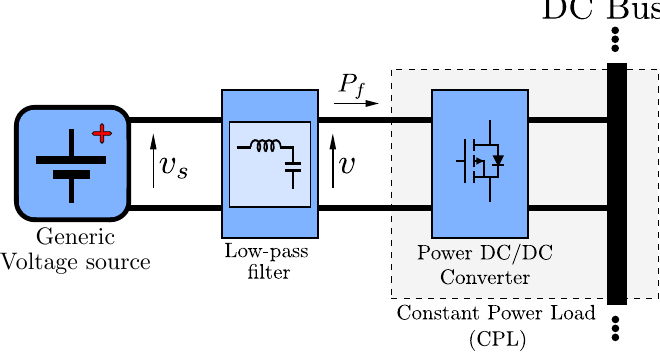
Figure 2. Schematic diagram of the Power Conditioning System (PCS) employed for the ZD